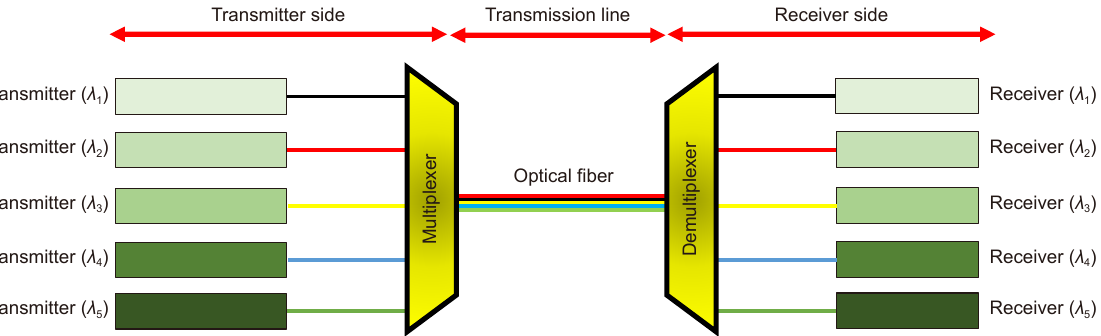
Fig. 3 | Schematic representation of one-directional WDM